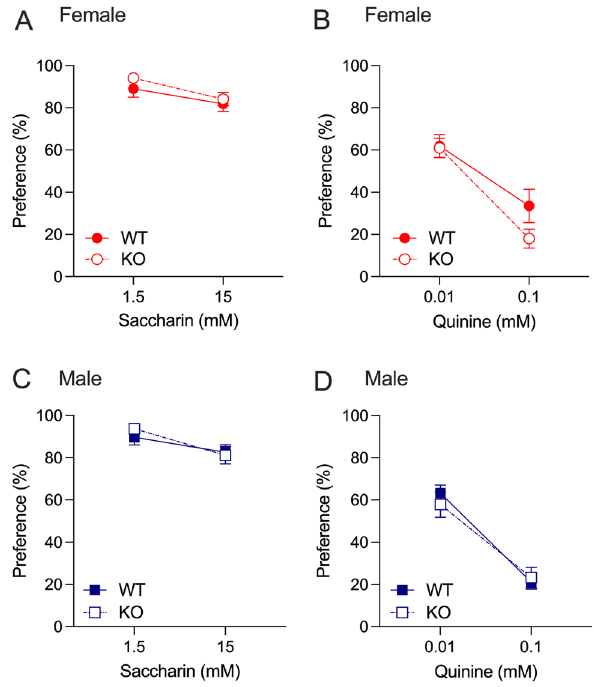
Figure 3. Saccharine and quinine consumption and preference in Hgfac WT and KO mice. Female Hgfac WT and KO mice showed no significant differences in ( A ) saccharine or ( B ) quinine preference. Male Hgfac WT